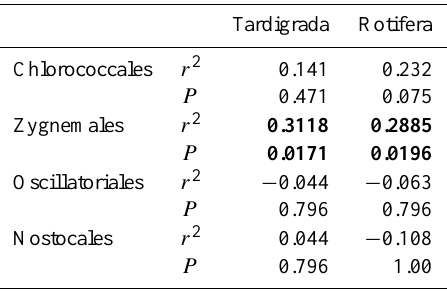
Table 4. Correlation table with Pearson’s r 2 values and corrected p values between microalgae and invertebrate grazers. Significant values are marked in bold.